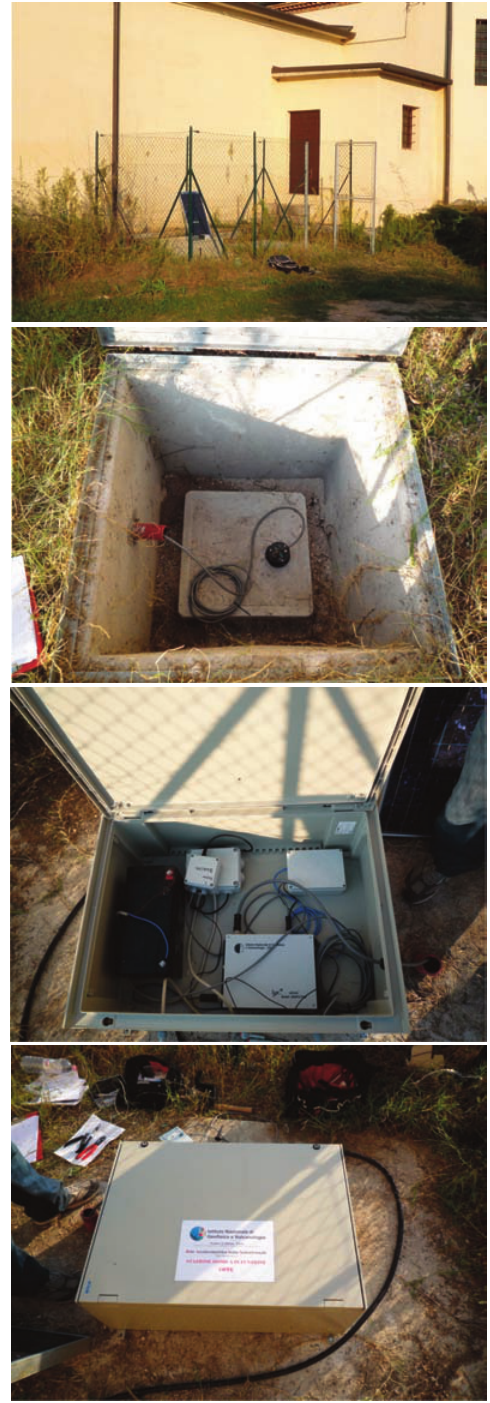
Figure 5. Typical installation arrangements. From top to bottom: external view; concrete basement where strong-motion sensor is anchored; plastic box that includes the recording system (open); plastic box